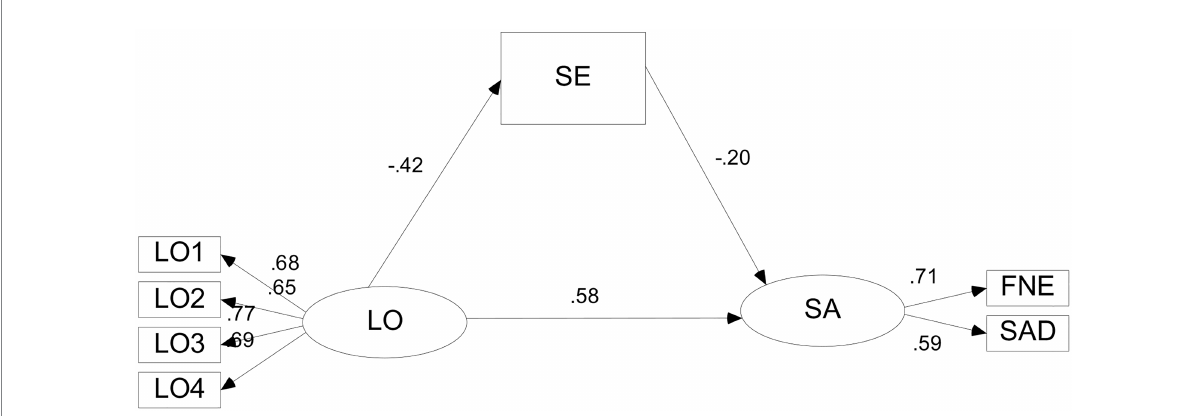
FIGURE 1 Standardized parameter estimates of the structural model demonstrating effects of loneliness on social anxiety via self-esteem. LO: Loneliness at home; SA: Social anxiety at school; SE: Self-esteem; n =